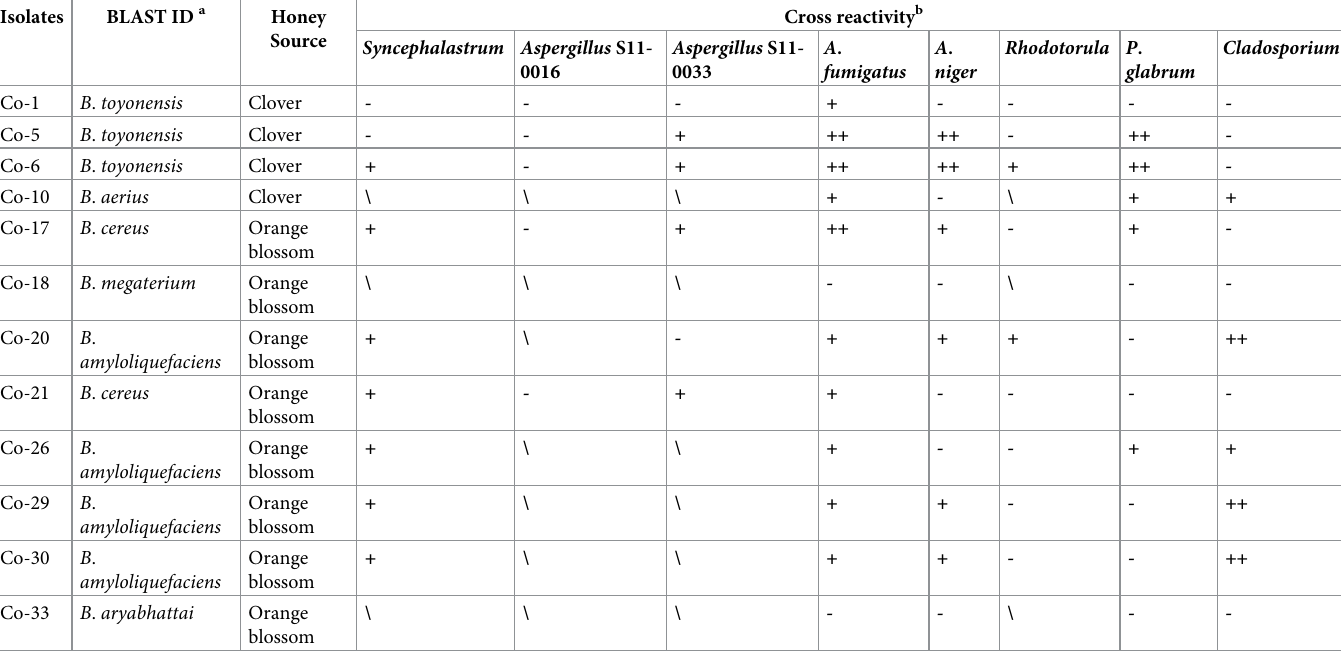
Table 1. Summary of identity, source, and cross-reactivity against food-associated fungal indicators of honey bacterial isolates. Isolates BLAST ID a Honey